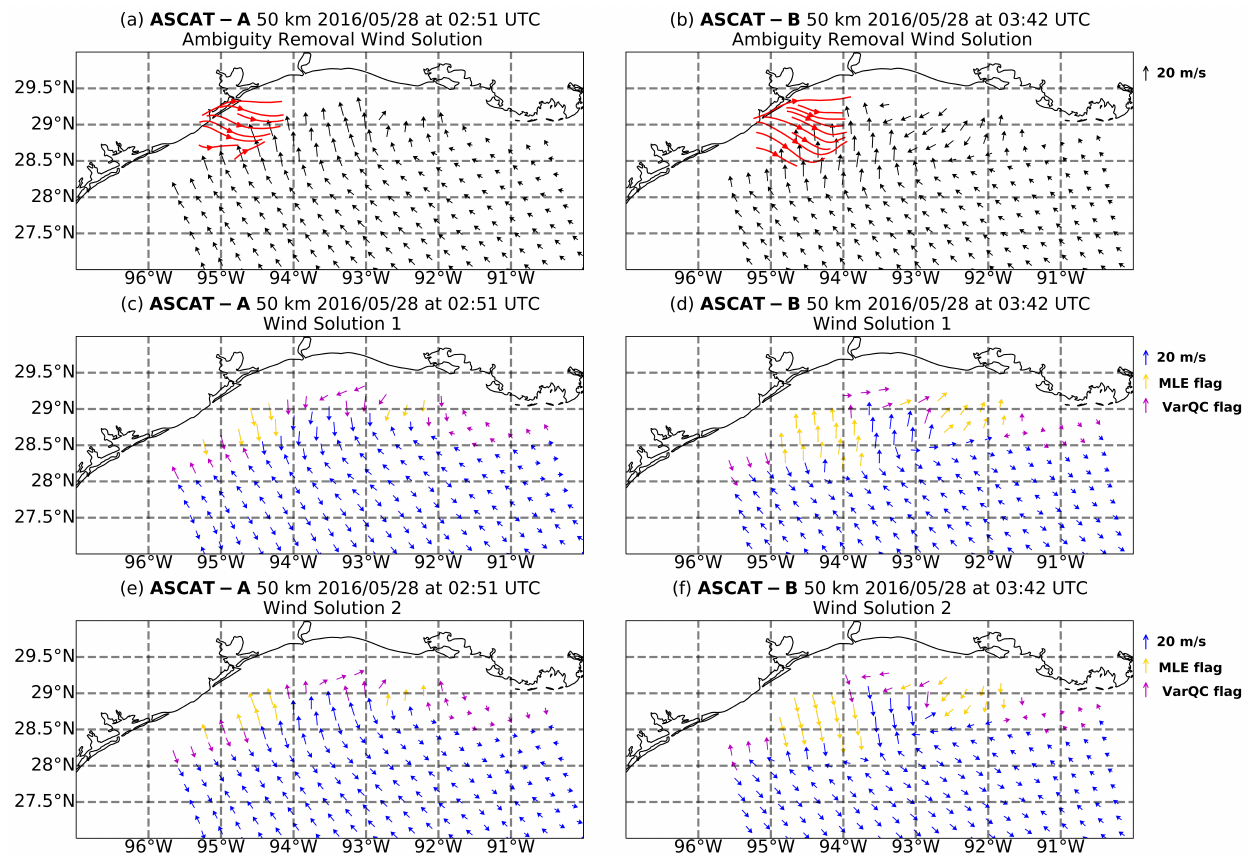
Figure 3. ASCAT-A and -B 50-km wind products on 28 May 2016 at 02:51 UTC and 03:42 UTC, respectively. Black vectors in ( a , b ) correspond to ASCAT-A, -B winds and red streamlines to radar-derived winds at the lowest elevation angle. ( c , e ) correspond to ASCAT-A wind solutions 1 and 2 of the available solutions. Blue vectors correspond to good quality wind retrievals, gold and magenta to retrievals for which the MLE and variational quality control flag has been activated, respectively. ( d , f ) have the same configuration as ( c , e ) but for